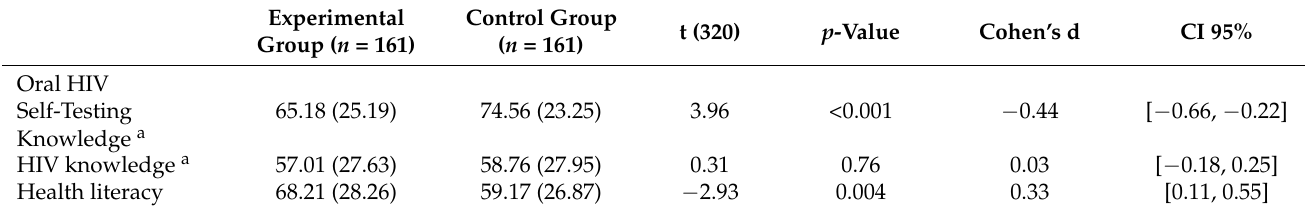
Table 2. Outcomes of interest between experimental group and control group ( n = 322).